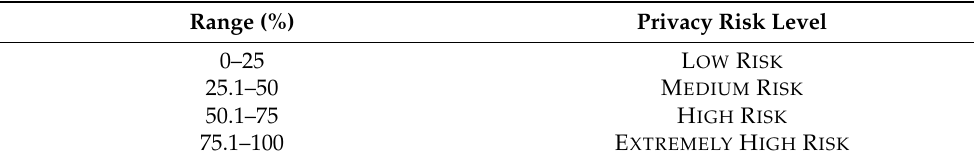
Table 8. Range of privacy risk Figure 8. Privacy exposure level vs. users.